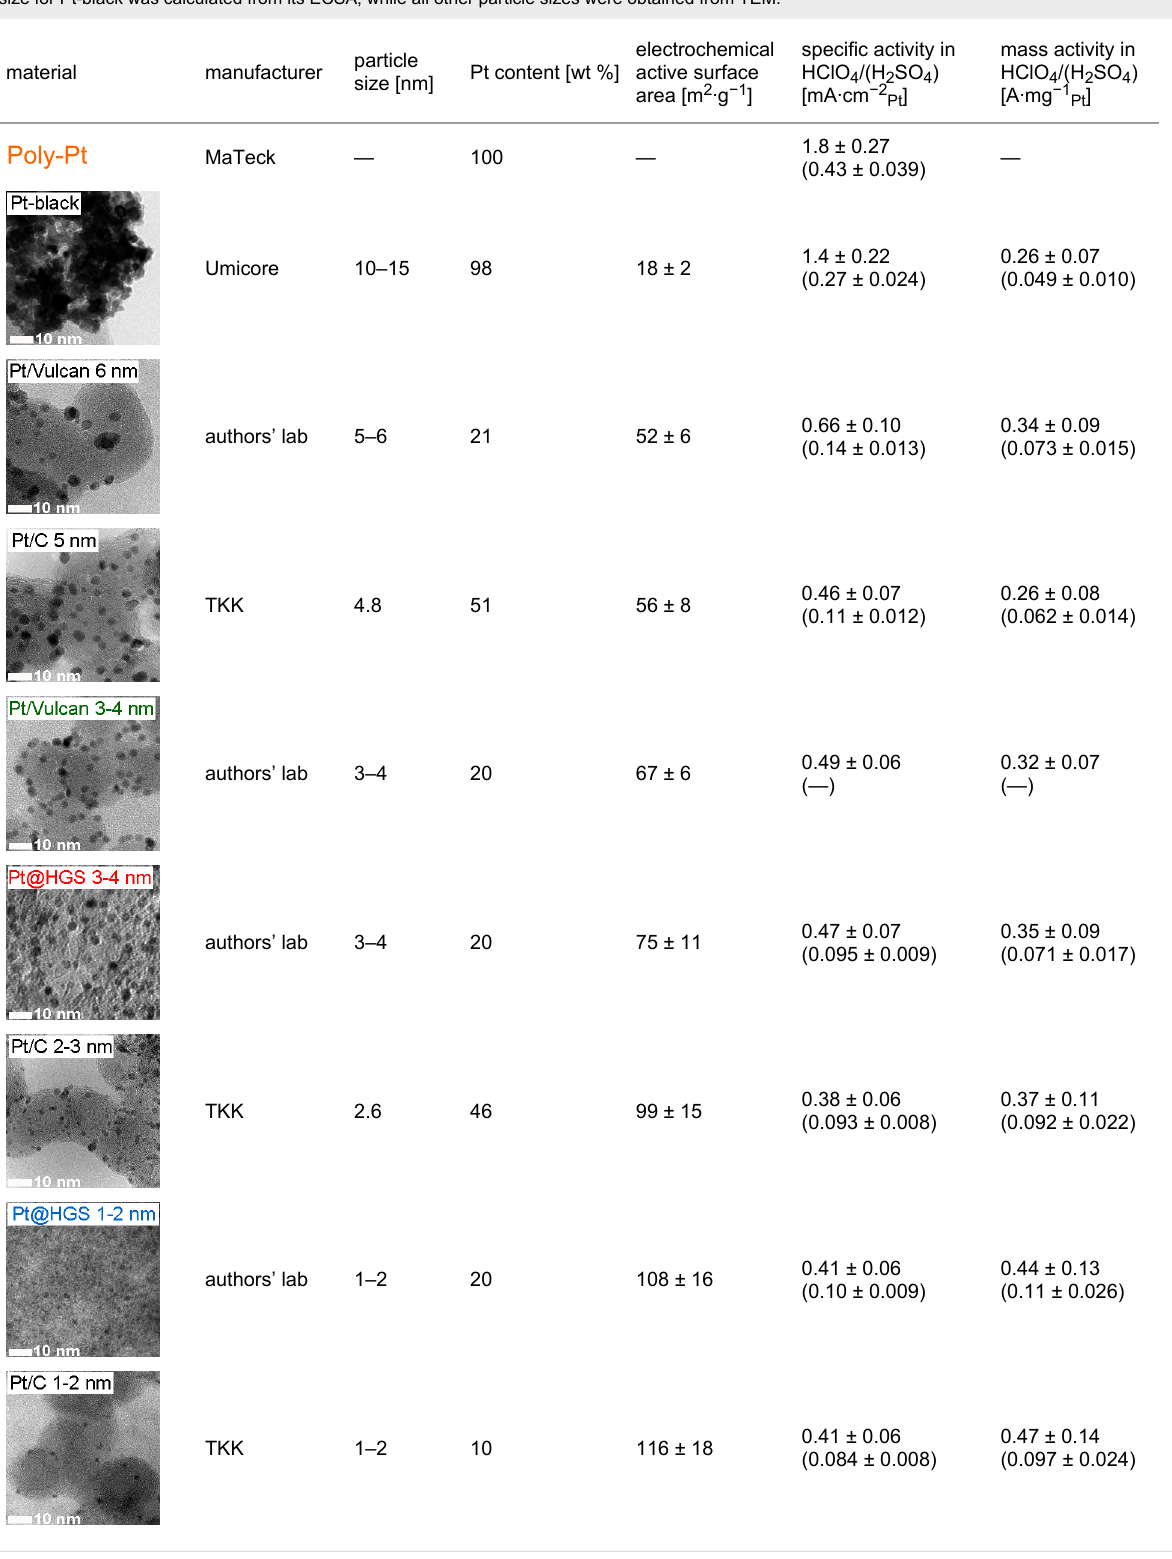
Table 1: The material and activity data of a small library of reference catalysts is summarized and compared to the three model Pt/C materials. TEM images of the reference catalysts with larger magnification are available in Supporting Information File 1 (see Figure S1). The particle diameters of Pt/C 5 nm, Pt/C 3 nm were provided by the manufacturer. The size derived from XRD is in good agreement with the results from TEM. The particle size for Pt-black was calculated from its ECSA, while all other particle sizes were obtained from TEM.